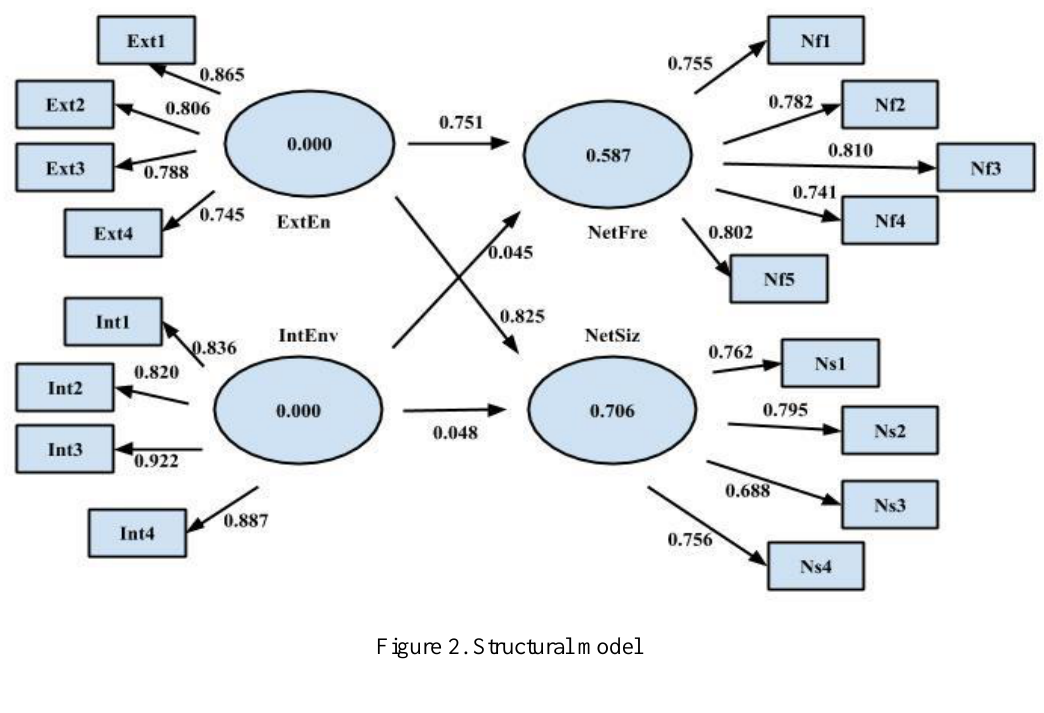
Figure 2. Structural model